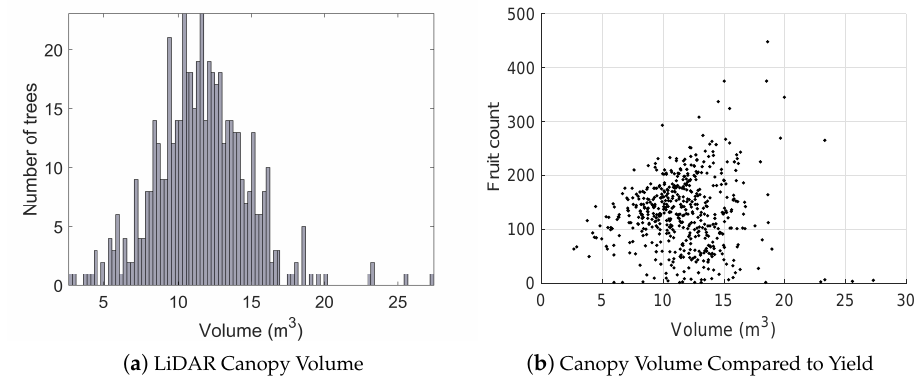
Figure 15. The clustering of fruit can be estimated by calculating the distance from each fruit to the next nearest: ( a ) histogram of nearest neighbour distances for all fruit in the orchard block. The relationship of mean neighbour distance to yield ( b ) follows a noisy inverse relationship. Two trees marked with a red cross have close to the average yield of 130 mangoes, with the minimum and maximum neighbour distances. These correspond to the the images in ( c , d ). In (c), the tree with the lowest mean neighbour distance shows a higher clustering, whereas (d) is the tree with the highest mean neighbour distance, showing a more even distribution of fruit in the canopy.